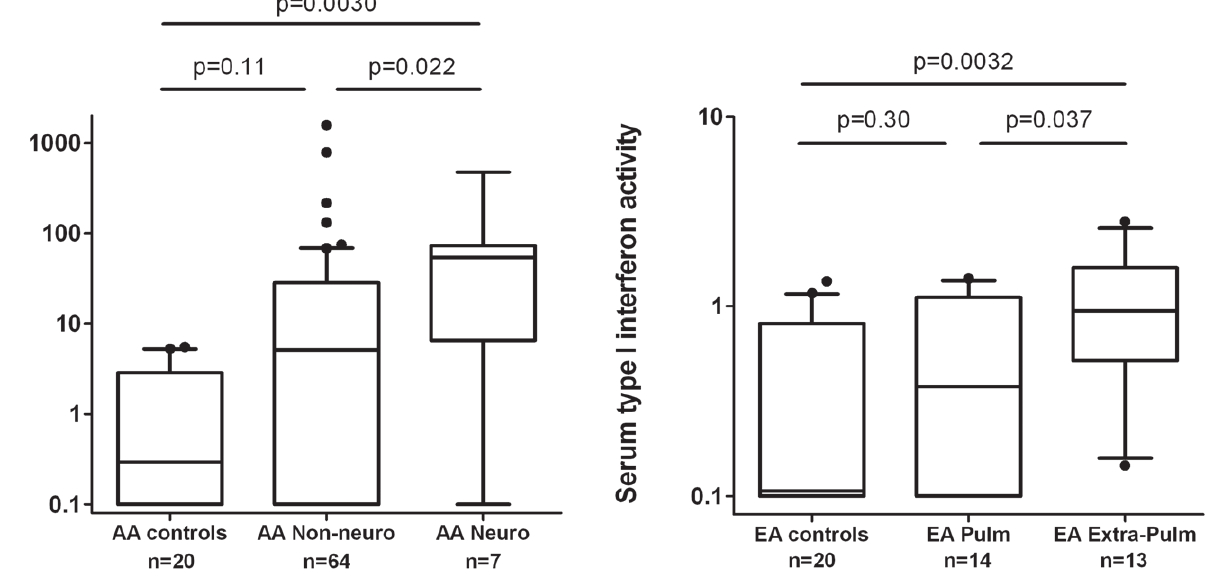
Figure 3. Serum TNF- a levels in African-American controls and sarcoidosis patients stratified by presence or absence of neurologic involvement. Lines represent the median, boxes show the interquartile ranges, and error bars show the 10 th and 90 th percentiles with dots indicating outliers. P-values by Mann-Whitney U test.